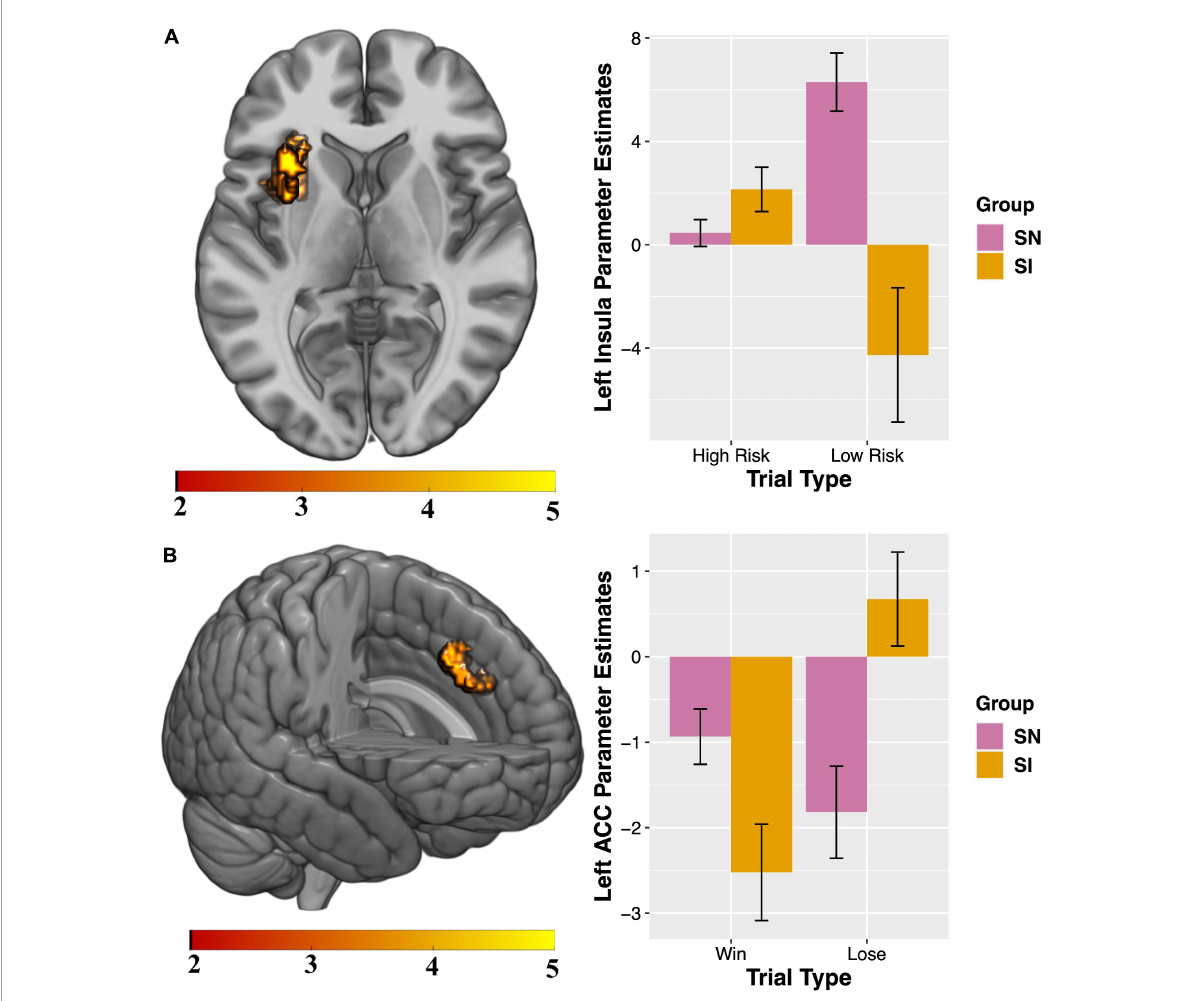
FIGURE2 Between-group results for which substance non-initiators (SN) participants demonstrate increased activation relative to Substance Initiators (SI) adolescents. Interaction charts depict mean parameter estimates (error bars represent standard errors) for (A) High-reward/risk > Low-reward/risk, left insula; and (B) Win > Lose, left anterior cingulate cortex (ACC). FSIQ as covariate of no interest. Initial cluster defining threshold = p < 0.001, k = 10 voxels. Results survive FWE cluster-correction at p <